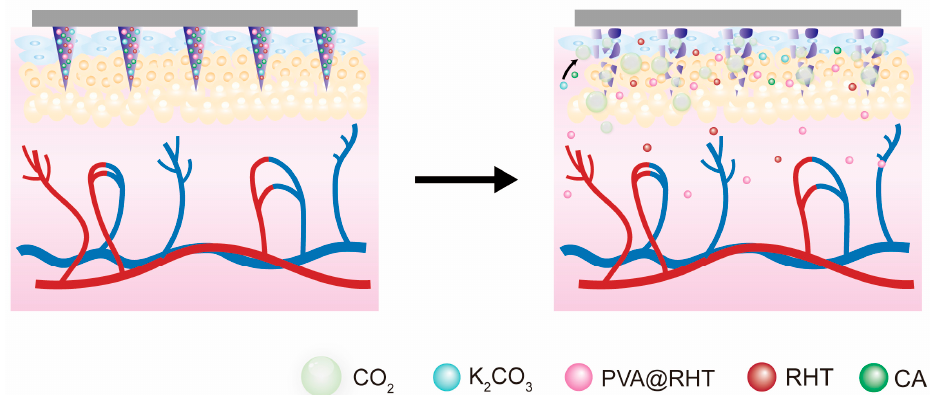
Figure 1. The mechanism diagram of the pneumatic initiators.